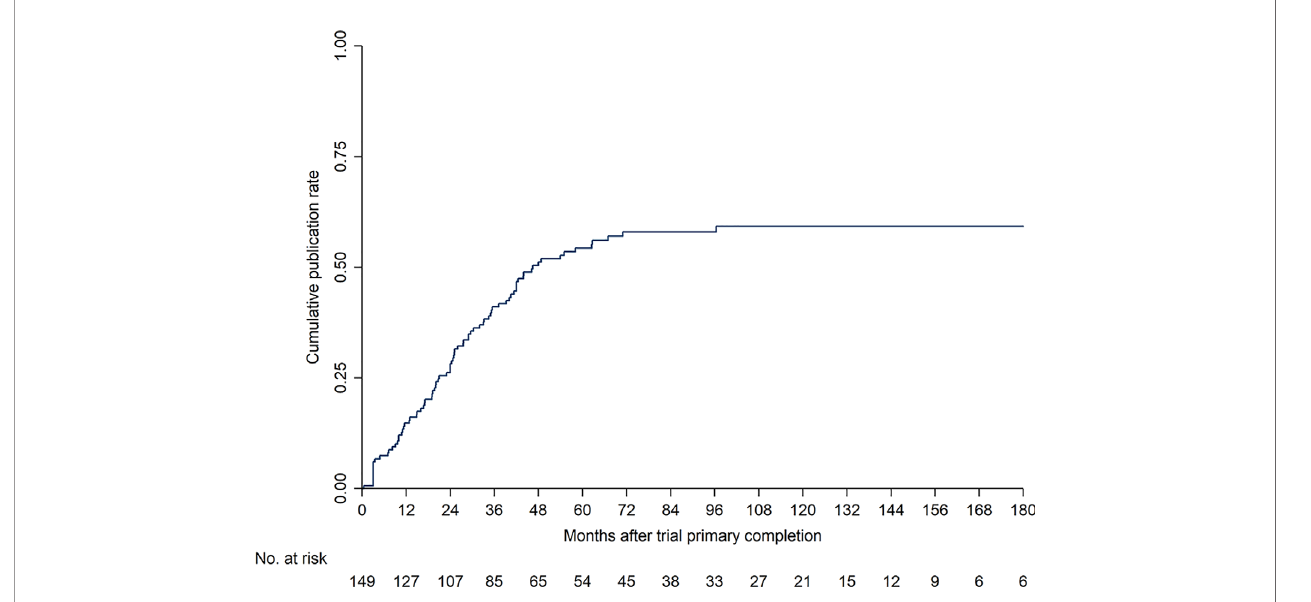
FIGURE 3 | Cumulative publication rate curve from trial primary completion to